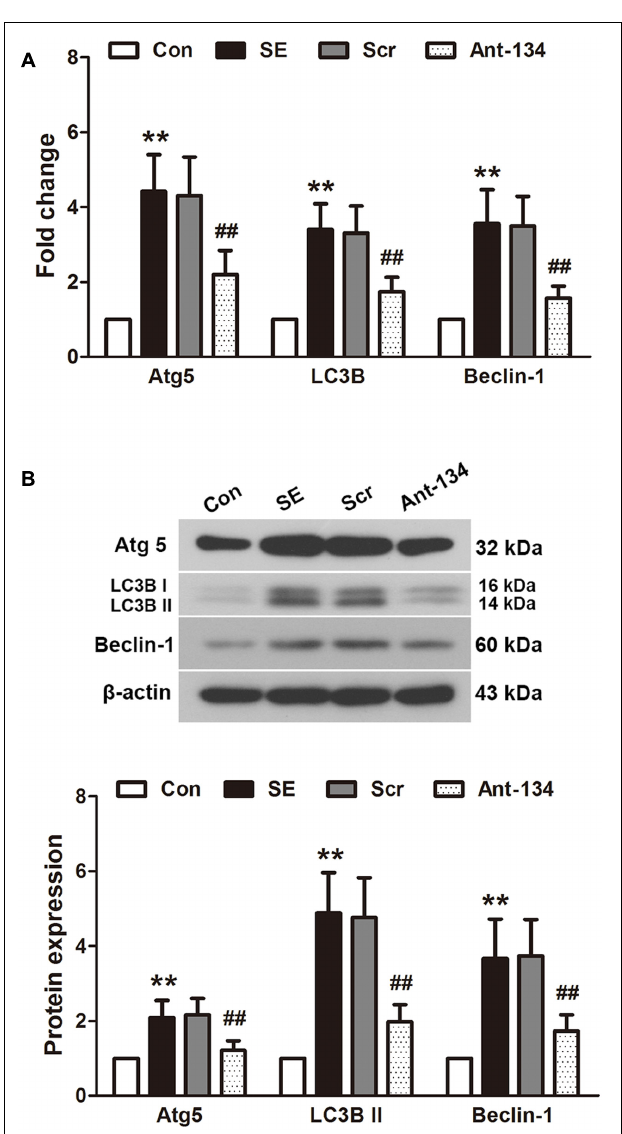
FIGURE 6 | Effects of Ant-134 on autophagy in the hippocampus of SE rats. Treatment of Ant-134 downregulated (A) mRNA and (B) protein expressions of Atg5, LC3B and beclin-1. Data are expressed as mean ± SD, n = 6. ∗∗ p < 0.01, versus the control group, ## p < 0.01, versus the SE